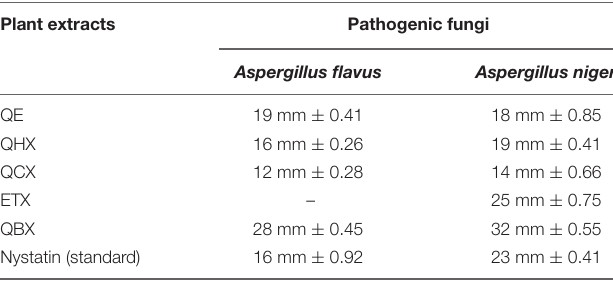
TABLE 5 | Minimum inhibitory concentration values Antifungal activity of extract measured at different concentrations (mg/ml).